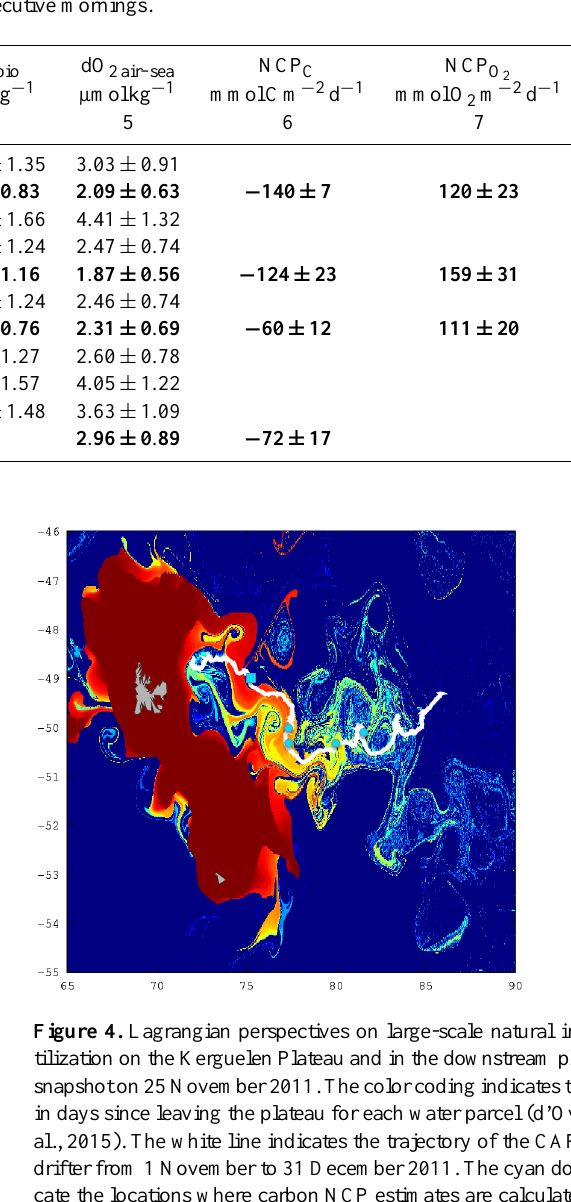
Table 2. Biological changes (columns 2 and 4) and air–sea flux changes (columns 3 and 5) of DIC and O 2 . Calculated values of NCP carbon and NCP oxygen (columns 6 and 7). In bold, mean values over consecutive mornings.